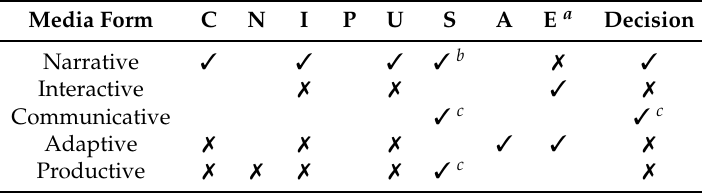
Table 3. Media form evaluation of generic learning trails. Relevant parameters are marked with (cid:51) if the condition is met and with (cid:55) otherwise. Unmarked entries do not have an impact according to Table 1. Values with a weak impact are shown for